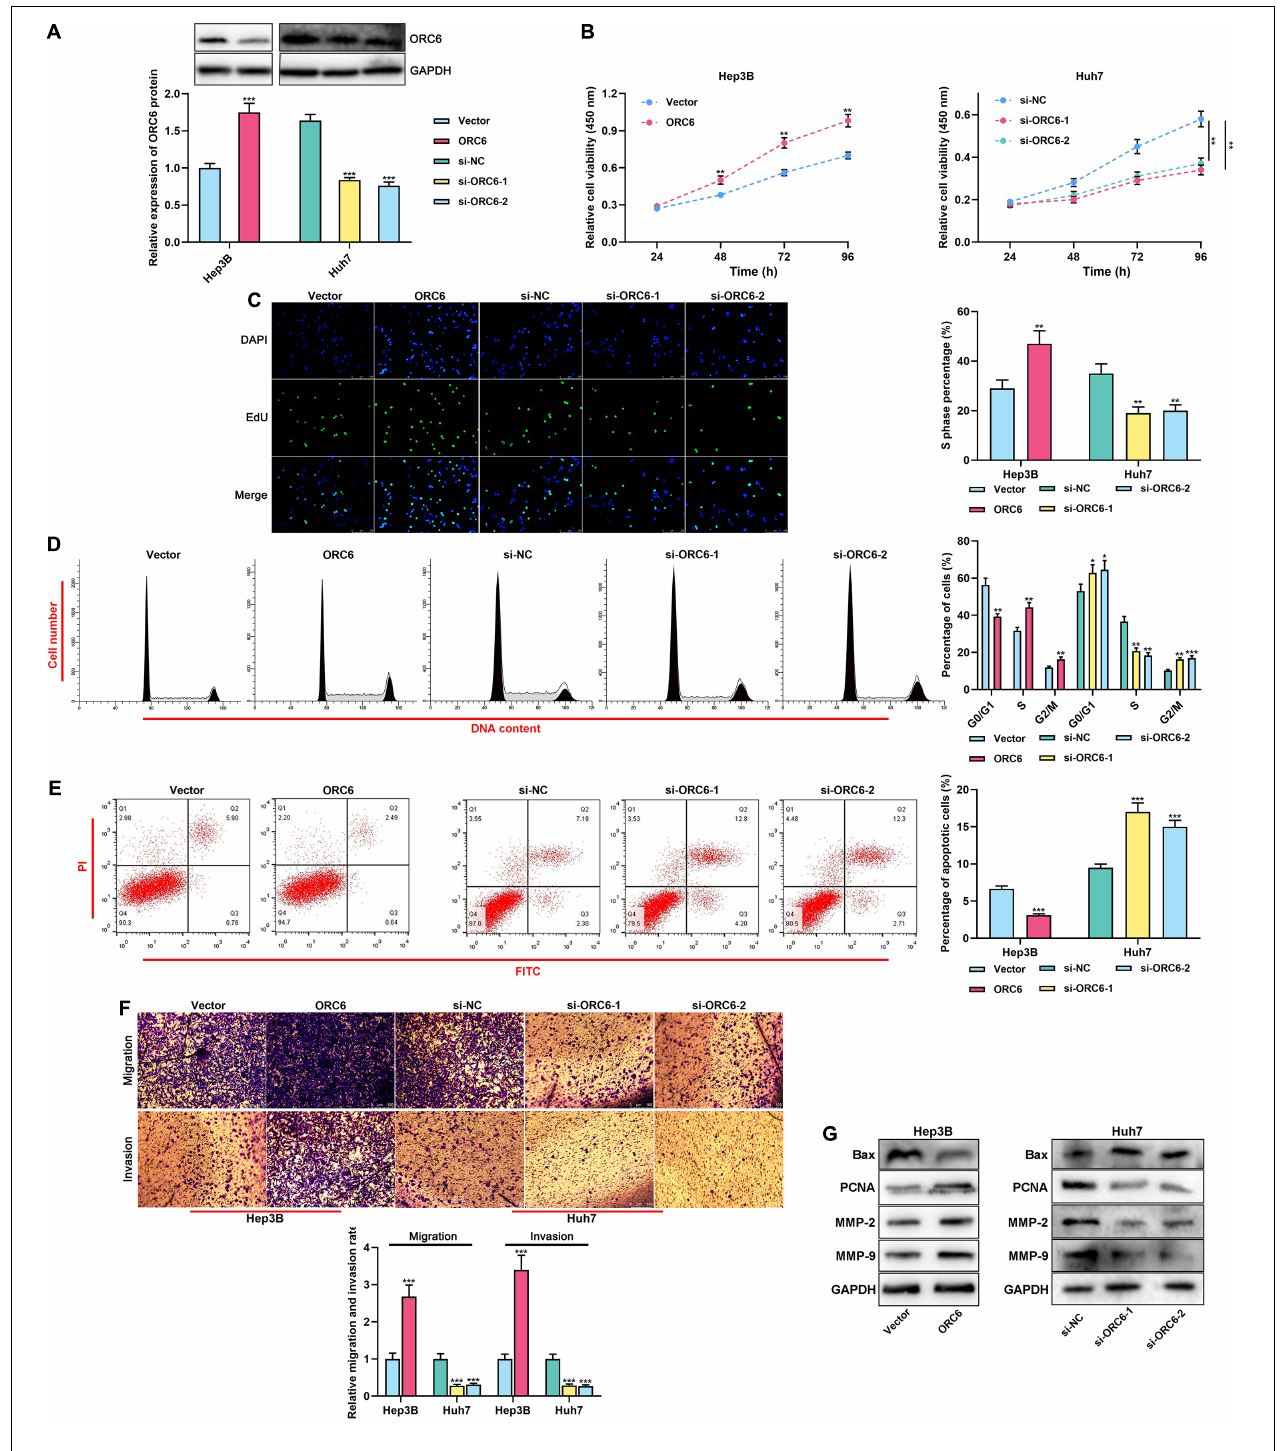
FIGURE 4 | ORC6 regulates the malignant biological behaviors of HCC cells. (A) Transfection efficiency of ORC6 overexpression plasmids and siRNAs was examined using Western blot. (B) After the transfection, the proliferation of Huh7 and Hep3B cells was detected employing a CCK-8 assay. (C) After the transfection, EdU assay was performed to determine the percentage of cells in the S phase. (D) After the transfection, flow cytometry was performed to analyze the cell cycle distribution of Huh7 and Hep3B cells. (E) After the transfection, apoptosis of Huh7 and Hep3B cells was validated using flow cytometry. (F) After the transfection, migration and invasion ability of Huh7 and Hep3B cells were measured through Transwell assay. (G) After the transfection, Western blot was used to detect the expressions of Bax, PCNA, MMP-2, and MMP-9 of Huh7 and Hep3B cells. All of the experiments were performed in triplicate. *, **, and *** represent p < 0.05, p < 0.01, and p < 0.001,